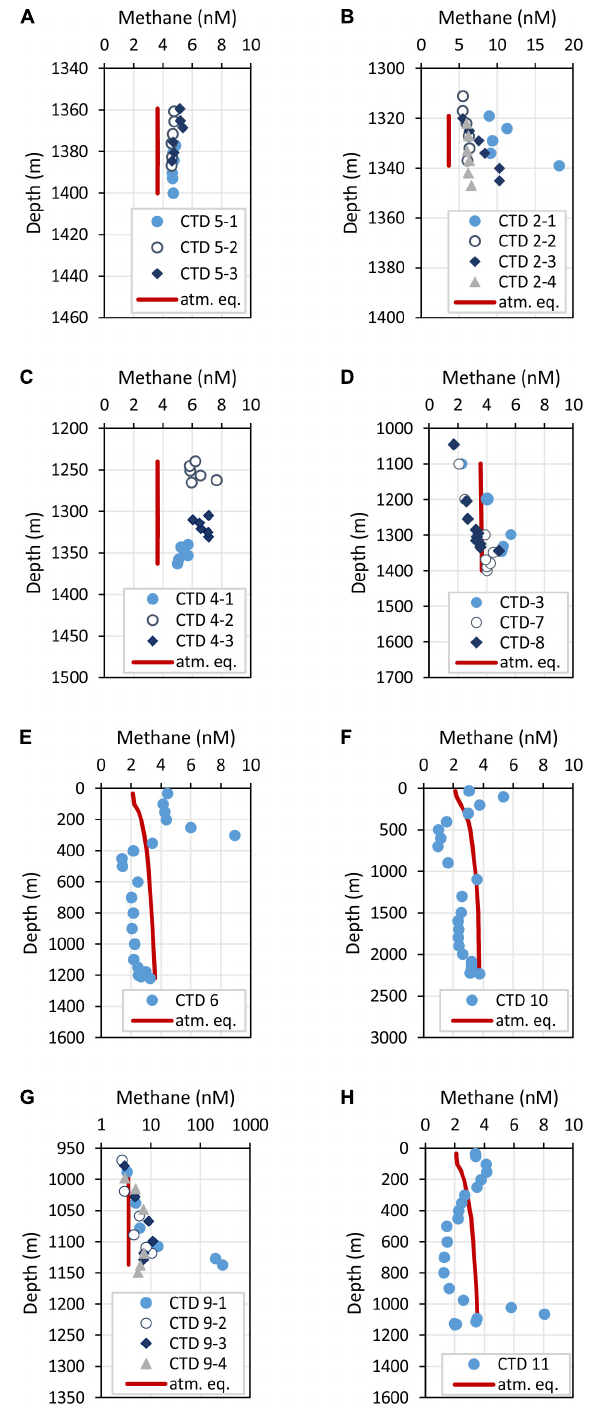
FIGURE 5 | Depth profiles of methane concentrations crossing two carbonate patches at FWCR (A,B) and the southern part of FWCR (C) . These data were used for methane flux estimation. Additional methane concentrations of water collected above FWCR are shown in (D) . CTD-7 was indented to sample the background at FWCR, CTD-3 was taken after collecting a gravity core and CTD-8 after gas emission was caused by Mebo-drilling and